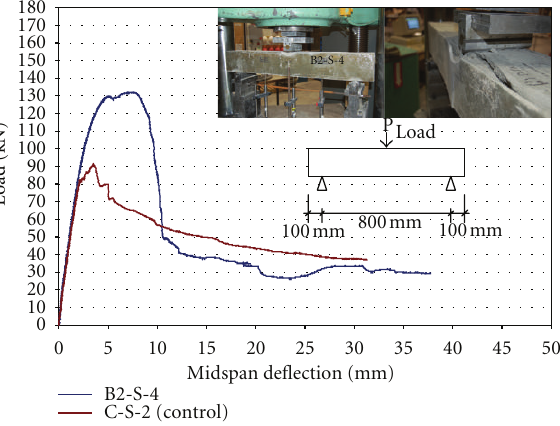
Figure 17: Load versus midspan deflection of RC beam B2-S-2.